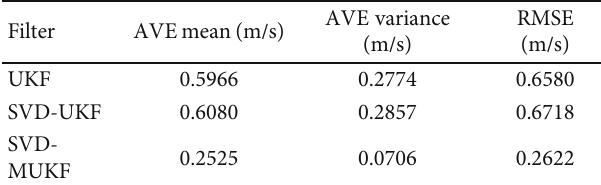
Table 3: Mean, variance, and RMSE of algorithm velocity data. Filter